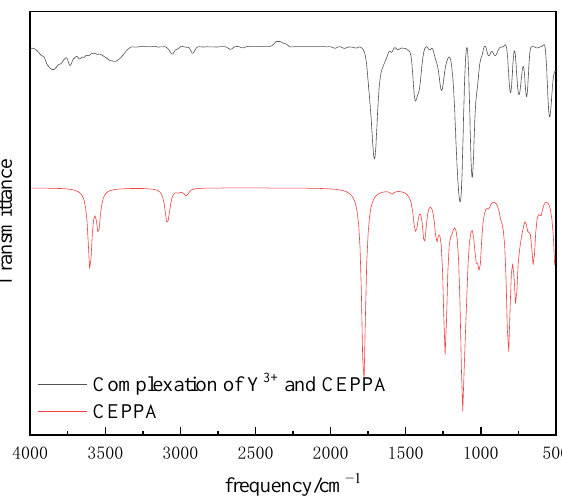
Figure 9. FTIR spectra of CEPPA and CEPPA complexation products with Y 3+.